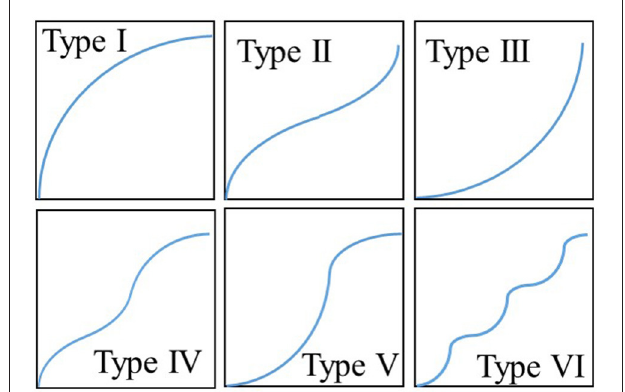
FIGURE 1 | IUPAC Six types of